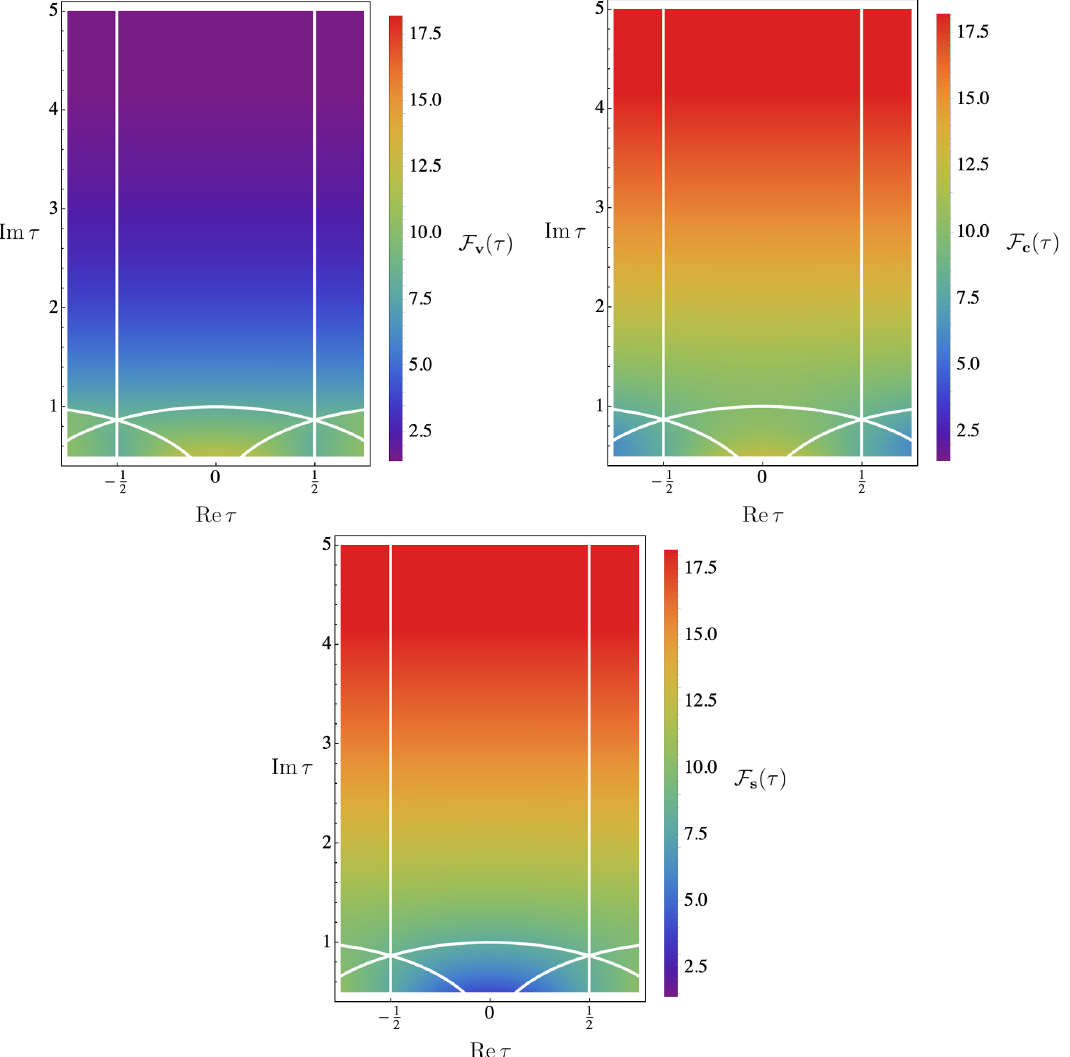
Figure 1 . The localization inputs F v , F c , and F s as a function of the complex coupling τ . White lines show boundaries between some of the fundamental domains of SL(2 , Z ) , with a focus on the standard fundamental domain | τ | > 1 , |< τ | ≤ 1 . Note that the triality related localization inputs 2 in different duality fundamental domains are related as in